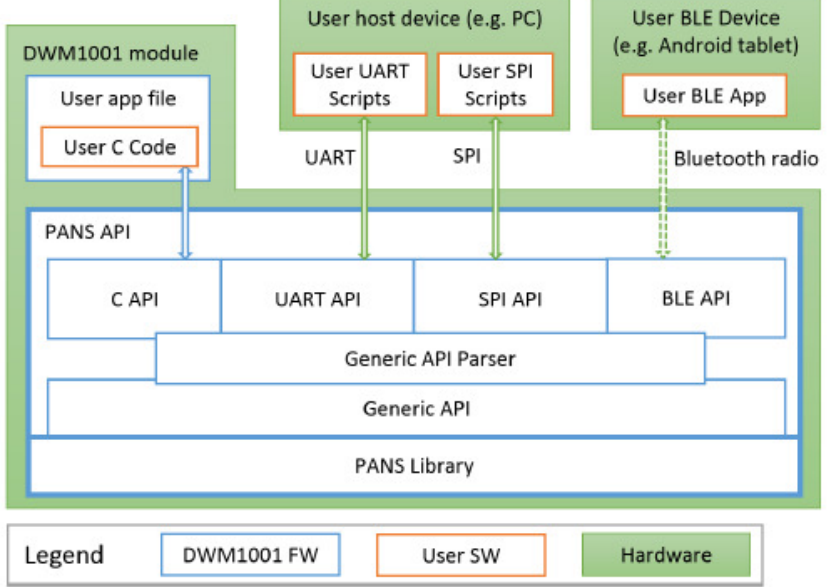
Figure 4. The four types of API through which we can individually access the ranges of each tag. There is an embedded API in the DWM1001 module accessible in C language, and other APIs to access by means of external equipment to the DWM1001 module through wired (serial COM) or wireless (BLE) connections